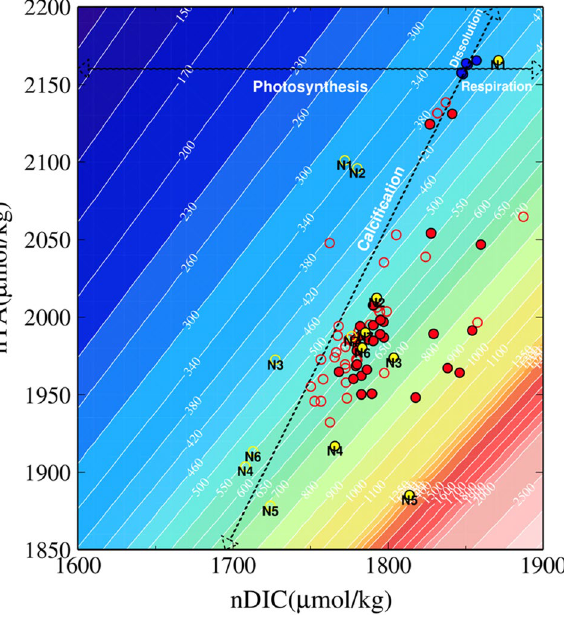
Figure 3. Salinity normalized TA-DIC diagram for the seawater collected around Nikko Bay. Data are normalized at the mean Nikko Bay salinity of 33.02 during the survey. Yellow symbols indicate data collected from N1 to N7 (Fig. 1c) during daytime (open) and at nighttime (filled). Red symbols indicate samples collected at other sites in Nikko Bay during daytime (open) and at nighttime (filled). Blue symbols indicate data collected at far offshore sites as end members. Trend lines indicating calcification, dissolution, photosynthesis, and respiration are drawn from these offshore end member values. Contours indicate p CO 2 isolines calculated at S = 33.02 and T = 30